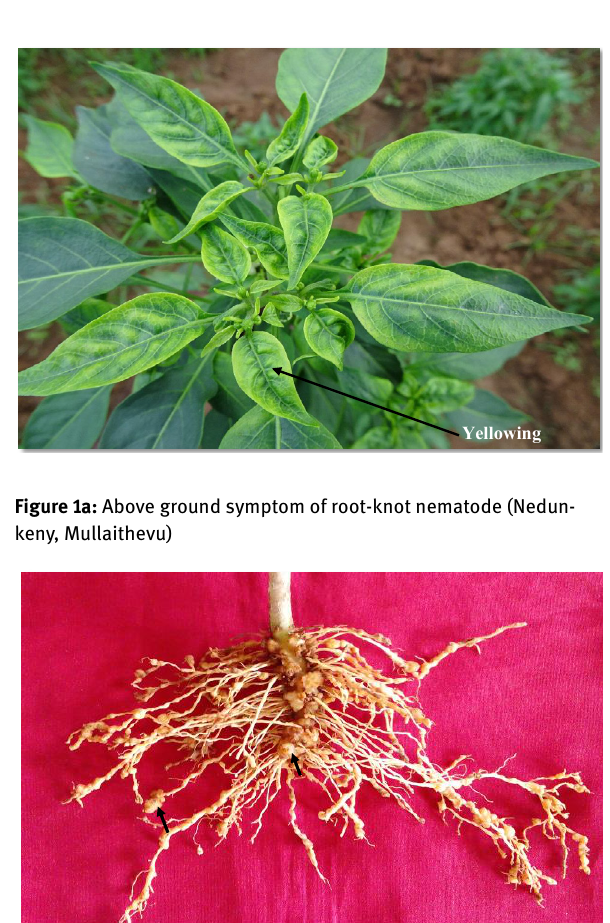
Female root- knot nematode